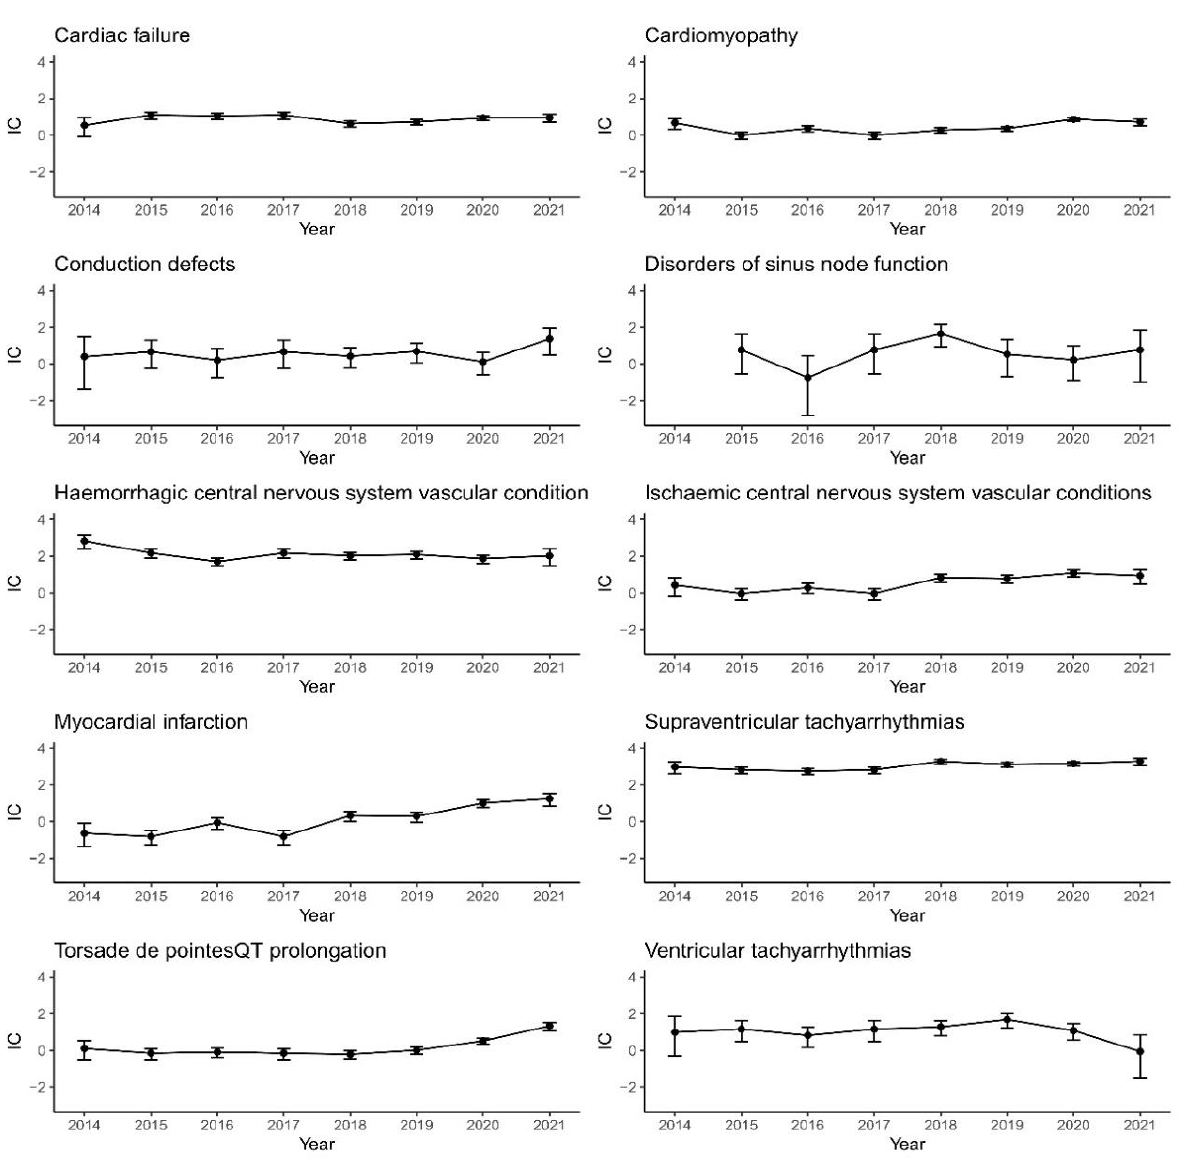
Figure 1. Information component ( IC) and its 95% CI over time for 10 signals.